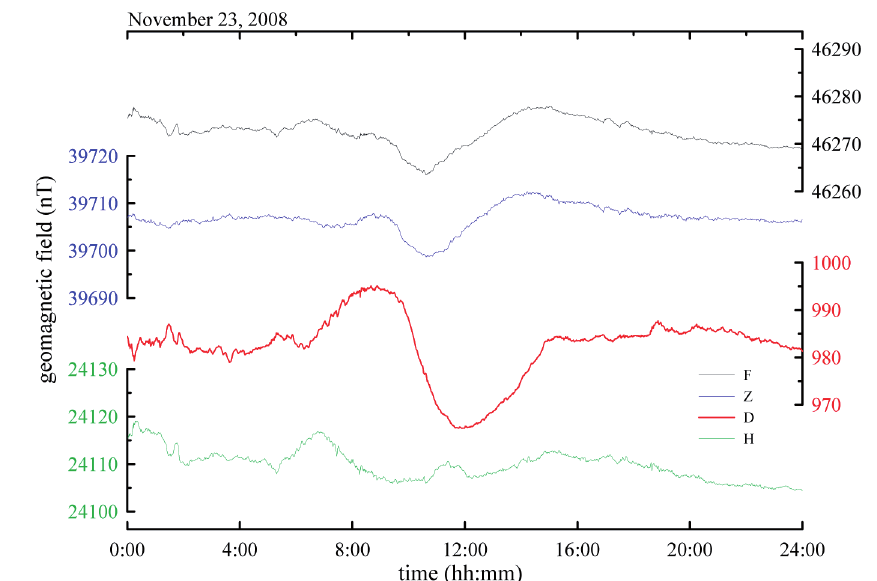
Fig. 5. One daecord of the geomagnetic field components with acquisition time resolution of one